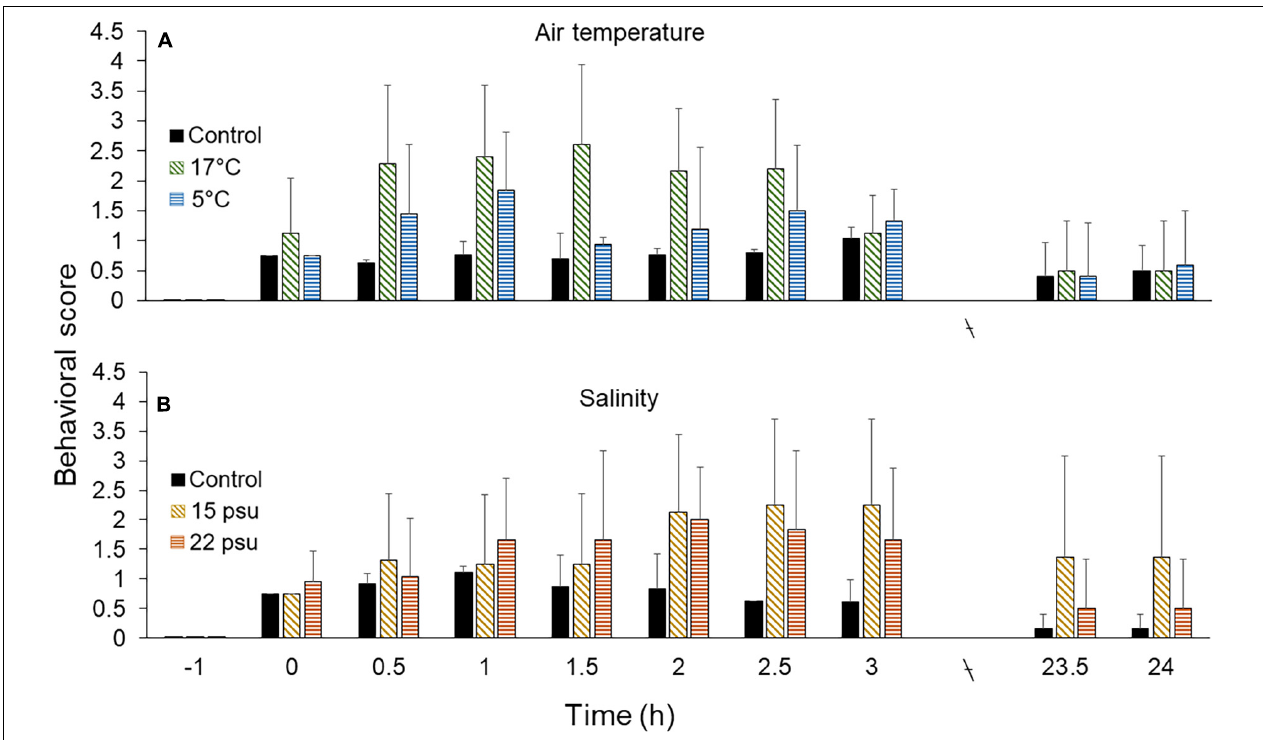
FIGURE 7 | Behavioral intensity (0 = resting/baseline state, 4 = maximum stress) in Cucumaria frondosa at various time points (–0.5 h = negative control, 0–24 h = positive control). (A) Comparison between controls and individuals exposed to 17 and 5 ◦ C air ( ± SD, n = 6). (B) Comparison between controls and individuals exposed to 15 and 22 psu salinity (mean ± SD, n =